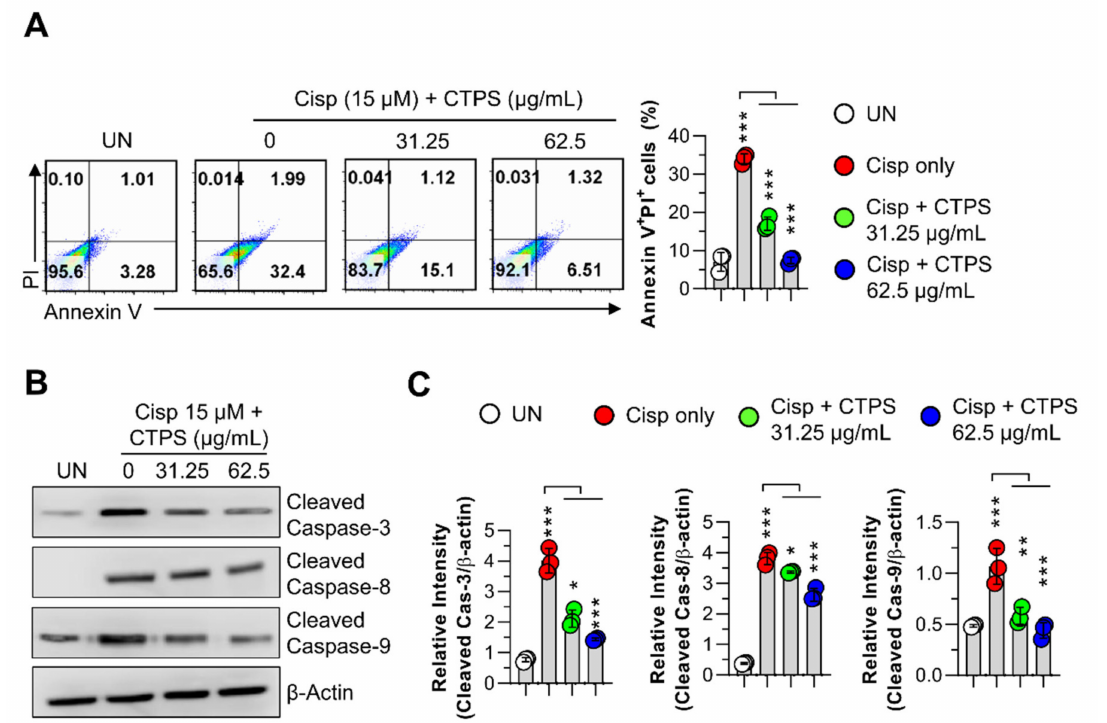
Figure 5. CTPS decreases cisplatin-induced apoptosis in BMDM. ( A ) BMDMs were pretreated with CTPS (31.25 and 62.5 µ g/mL) for 2 h and then treated with 15 µ M cisplatin for 24 h and analyzed via flow cytometry after performing Annexin V/PI staining. Cells were analyzed via flow cytometry using the FACSVerse TM flow cytometer. The dot plots are representative data of three independent experiments. ( B ) Following pretreatment with CTPS (31.25 and 62.5 µ g/mL) for 2 h, non- or CTPS-treated BMDMs were stimulated with 15 µ M cisplatin for 24 h and lysed. Proteins in cell lysate were evaluated via western blotting. Protein expression of cleaved caspase-3, 8, and 9 in the cell lysate. β -actin was used as the loading control for cytosolic fractions. ( C ) The relative band intensity of each protein is expressed as a percentage. The data are expressed as the mean ± standard deviation ( n = 3). * p < 0.05, ** p < 0.01, or *** p < 0.001. UN: untreated cells; CTPS, Cudrania tricuspidata -derived polysaccharides; cisp, cisplatin; BMDMs, bone marrow-derived macrophages; PI, propidium